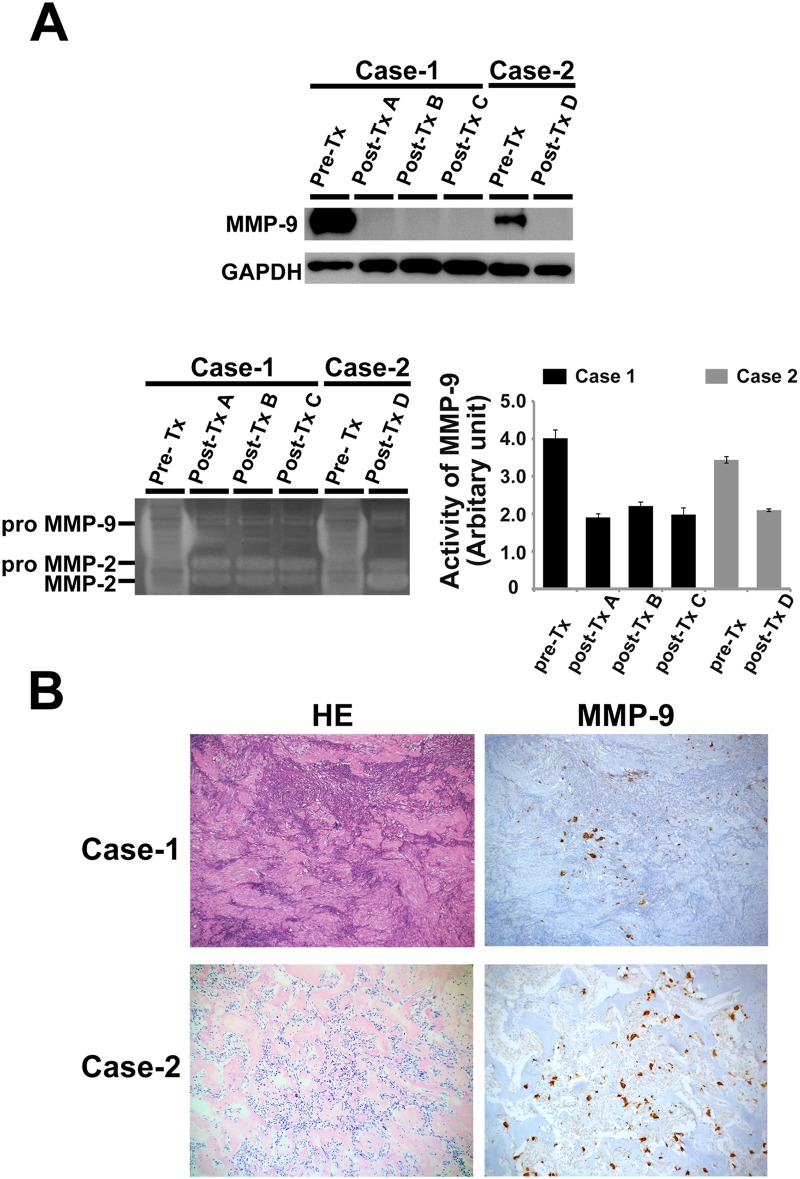
A validation study on the expression and activity of MMP-9 in the test set.(A) Western blot analysis showed that treatment with denosumab resulted in a marked decreased in the expression levels of MMP-9 in cases 1 and 2 (upper panel). A zymogram indicating that gelatinolytic activity is decreased in post-Tx samples in comparison to pre-Tx samples in cases 1 and 2 (lower left panel). The bar graph shows the quantitative results of zymography (lower right panel). (B) In both the post-Tx samples (cases 1 and 2), HE stain showed that the reduction of osteoclast-like giant cell numbers and the replacement of tumor cells were by the fibroosseous tissue (left panels). In both the post-Tx samples (cases 1 and 2), the immunohistochemical analyses showed the expression and localization of MMP-9 in both stromal cells and osteoclast giant cells (right panels).